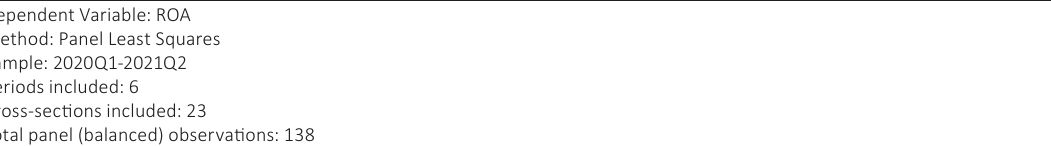
Table 2. Results of OLS model for Model-1